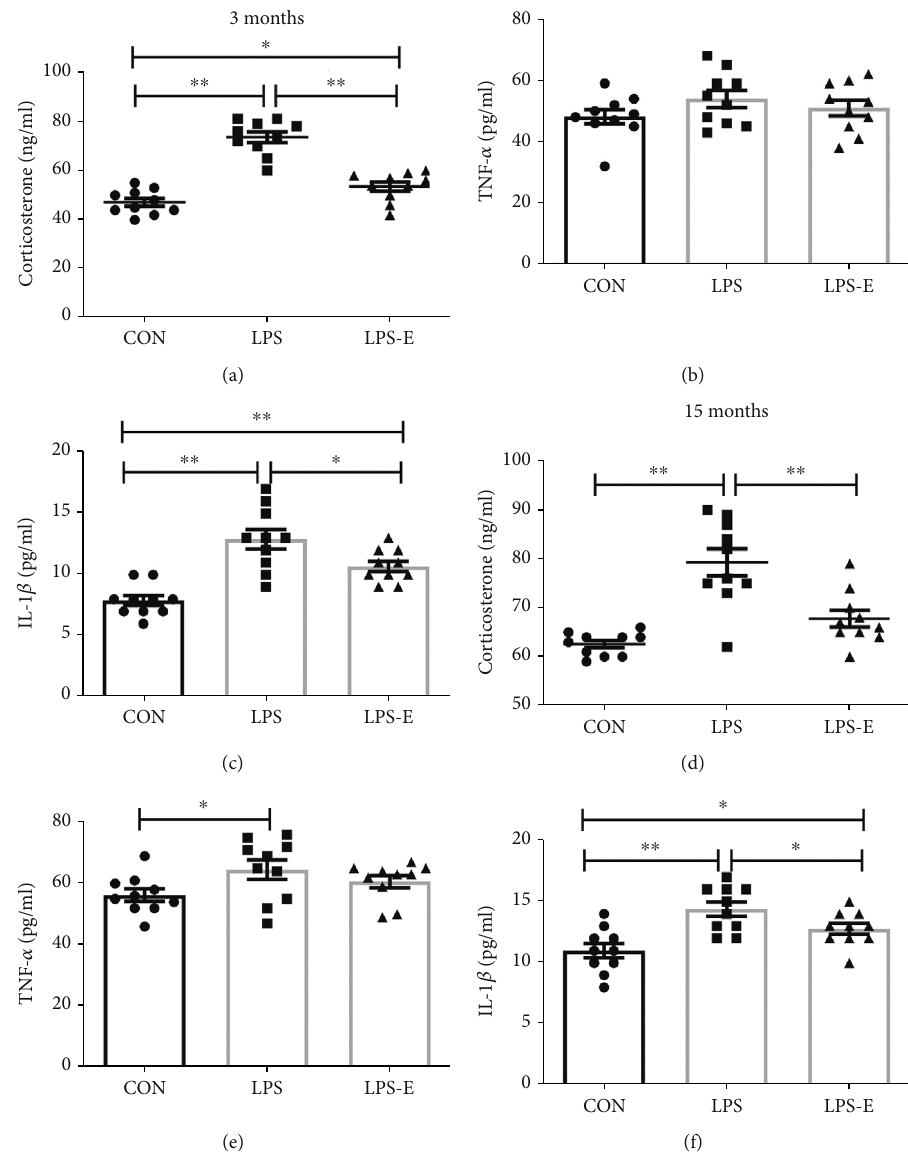
Figure 3: Plasma levels of corticosterone, TNF- α , and IL-1 β levels in the CON, LPS, and LPS-E groups in o ff spring at 3 months (a) – (c) and 15 months (d) – (f). All data are depicted as mean ± SEM ( n = 10 per group). Signi fi cance is as follows: ∗ P < 0 : 05 ; ∗∗ P < 0 : 01